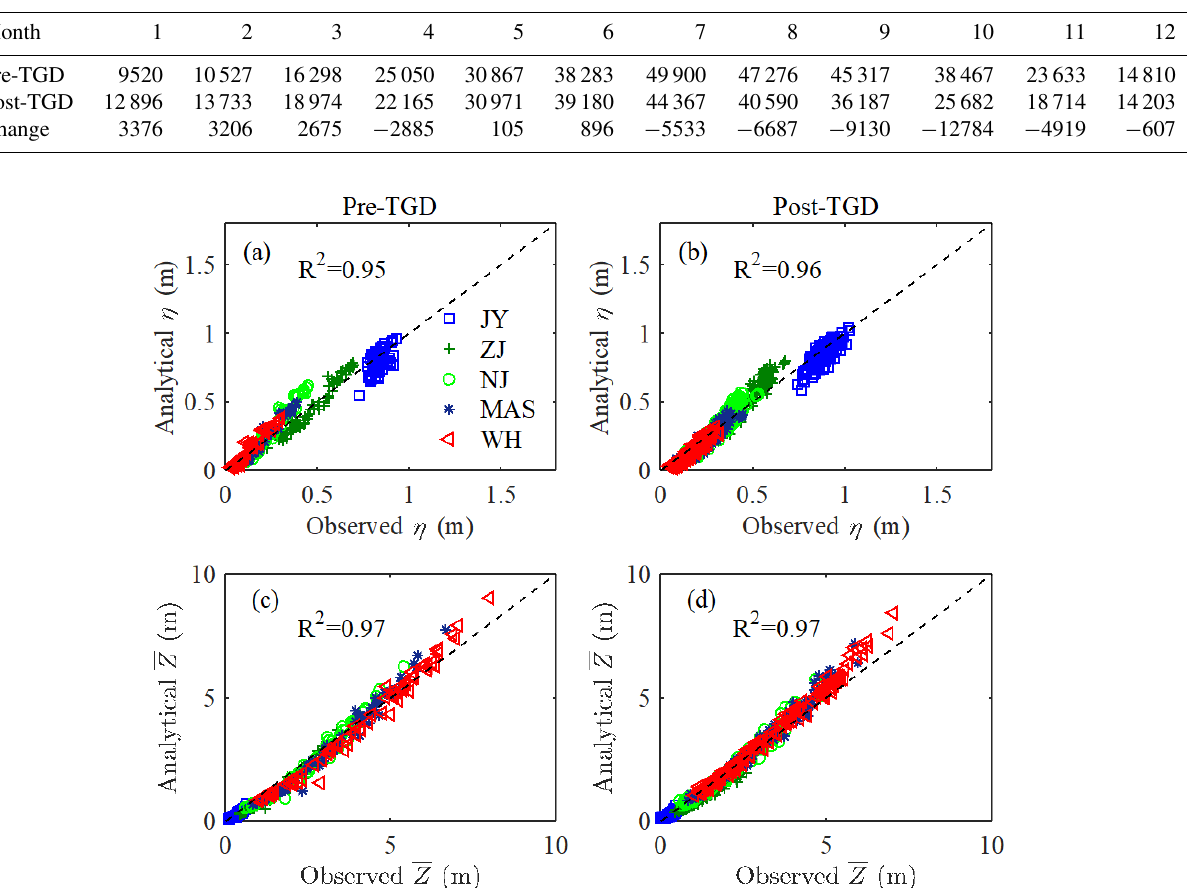
Figure 5. Comparison of monthly averaged values for (a, b) analytically computed tidal amplitude η and (c, d) residual water level Z against the observations in the Yangtze River estuary for the pre-TGD period (1979–1984) and post-TGD period (2003–2014).